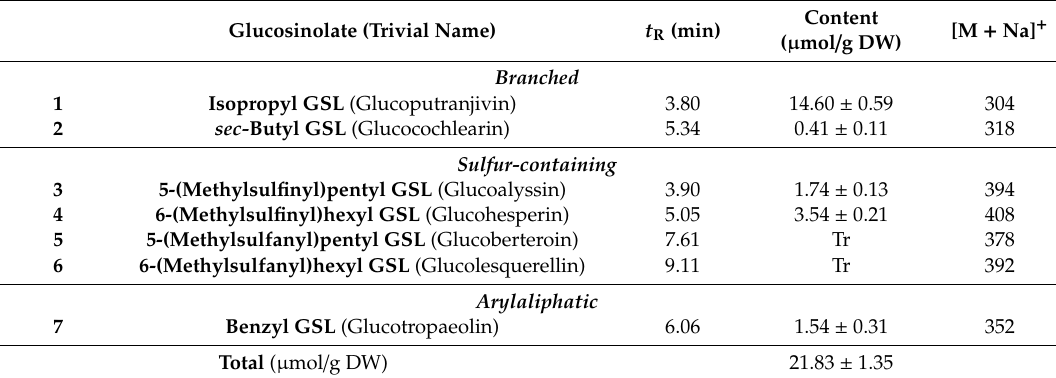
Table 1. Individual glucosinolate content ( µ mol / g DW) in L. annua seed.